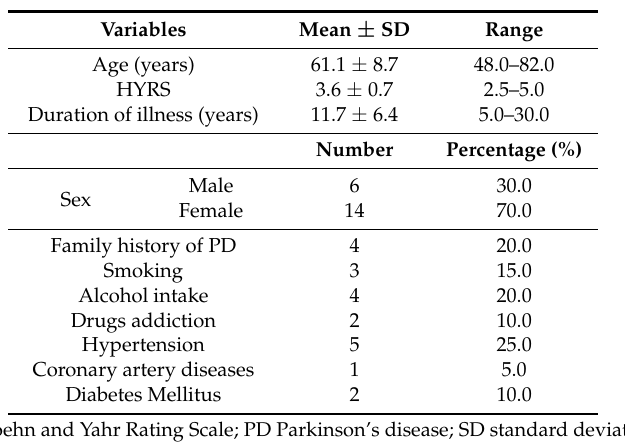
Table 1. Preoperative demographic and medical characteristics.